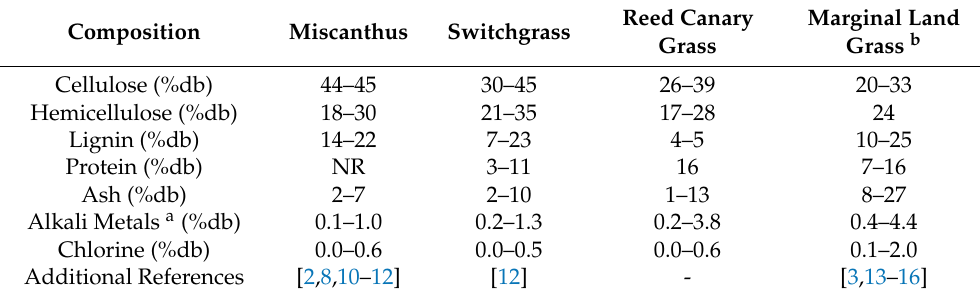
Table 1. Comparative biochemical composition of different grass